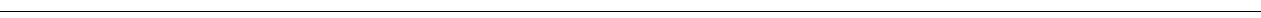
Fig. 4 Cell-based glycan arrays for screening Siglec-15 ligands. a The work fl ow for the construction of cell-based glycan arrays on the cell surface of Lec2 cells using a chemoenzymatic strategy for screening speci fi c and high-af fi nity Siglec-15 ligands. Cells were fi rst treated with ST6Gal1 and the alkyne functionalized CMP-sialic acid analog 7 , followed by reacting with a library of azide-containing molecules via the biocompatible CuAAC to form a cell- based glycan array. The modi fi ed cells were incubated with Siglec-15-Fc pre-complexed with Anti-human IgG APC, then analyzed by fl ow cytometry. b Flow cytometry data presented in bar graph. Fold difference in MFI of Siglec-15 Fc binding was determined by comparison with the negative control (no transfer of 7 ) ( n = 3, error bars are reported as SEM). c Structures of CMP-SiaA13 ( 10 ) and CMP-SiaA31 ( 11 ) and resulting glycan structures after sialyltransferase-mediated cell-surface glycosylation. d Siglec-15-Fc binding after the one-step labeling of Lec2 CHO cells using ST6Gal1, ST3Gal1 or ST3Gal4-mediated transfer of 10 or 11 , respectively. Fold difference in MFI of Siglec-15 Fc binding was determined by comparison with the negative control ( n = 3, error bars are reported as SEM). e Evaluating the speci fi city of α 2-6-linked Siglec-15 ligands, α 2-6-10 and α 2-6-11 ( n = 3, error bars are reported as SEM). f Evaluating the speci fi city of α 2-3-linked Siglec-15 ligands, α 2-3-10 and α 2-3-11 ( n = 3, error bars are reported as